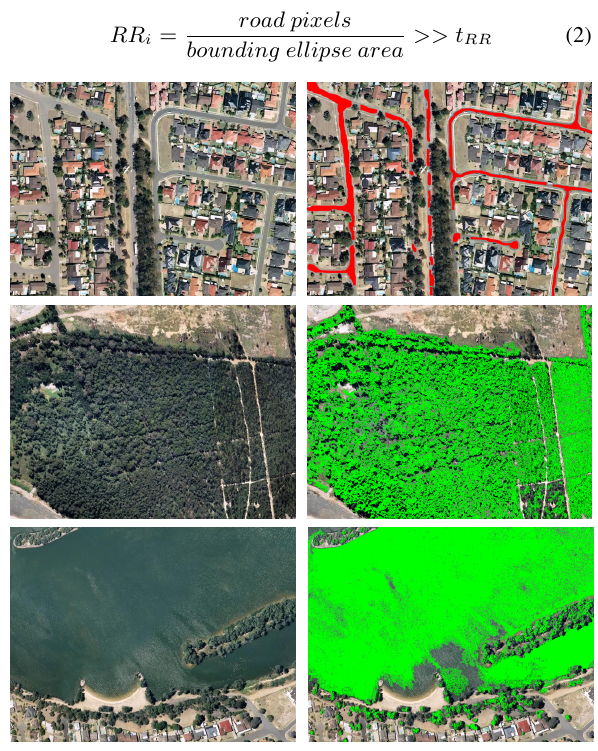
Figure 2: Training images and ground truth shown for road, greenery and water classes